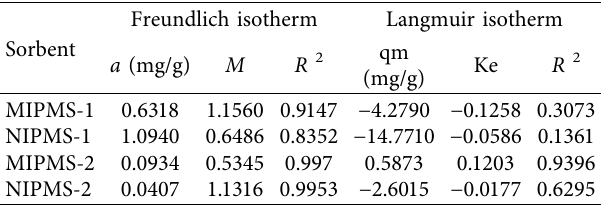
Table 5: % recovery of salbutamol and terbutaline in serum spike